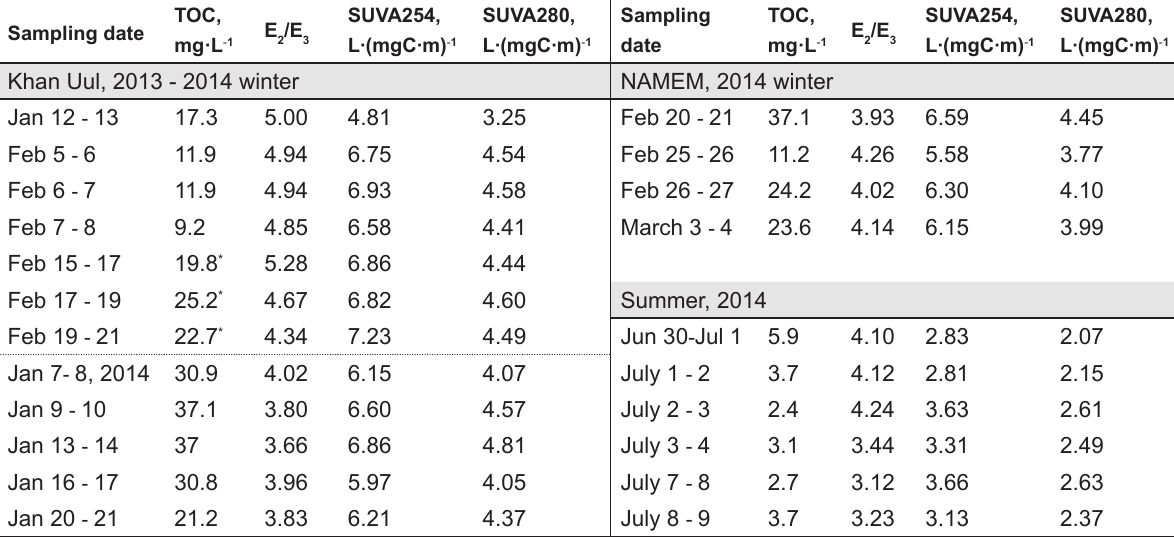
Table 4. Absorbance of HULIS fraction extracted by the DEAE